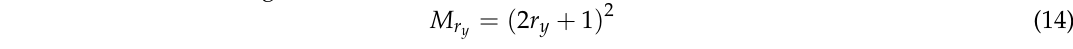
Algorithm 8: Reproduction of